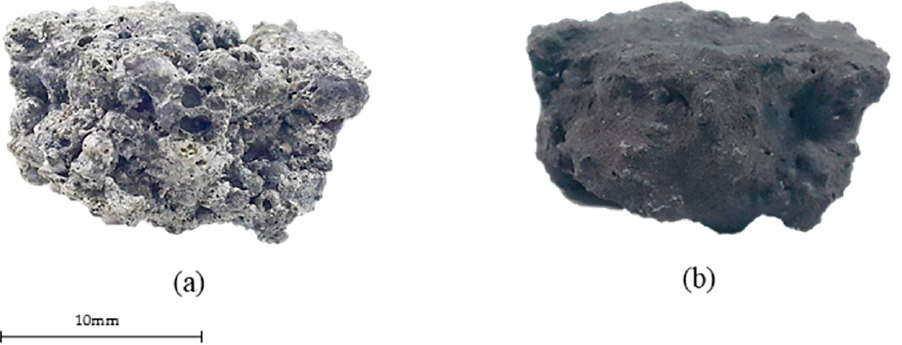
Figure 8. POC particle: ( a ) Pre-coating; ( b ) After coating.